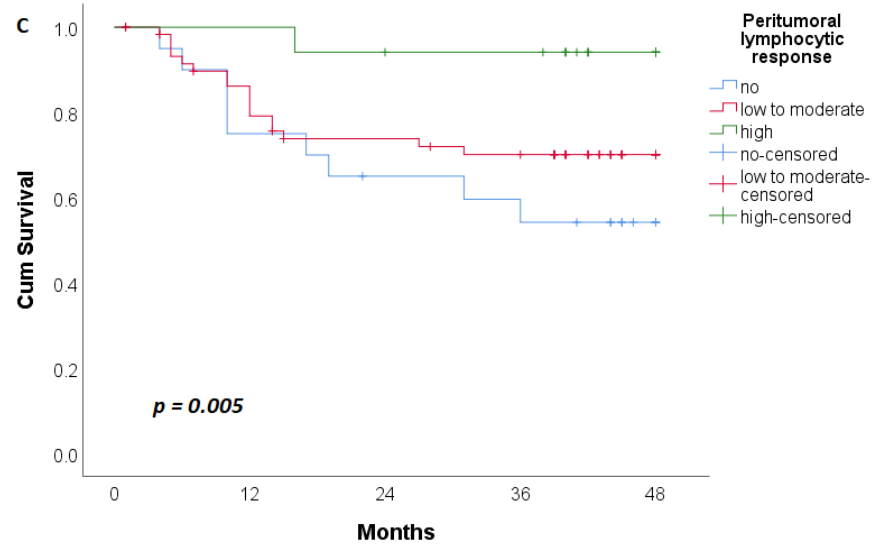
Figure 2. Kaplan–Meier disease-free survival curve in patients relative to: ( A )—the TNM stage; ( B )—presence of tumor deposits; ( C )—peritumoral lymphocytic response.